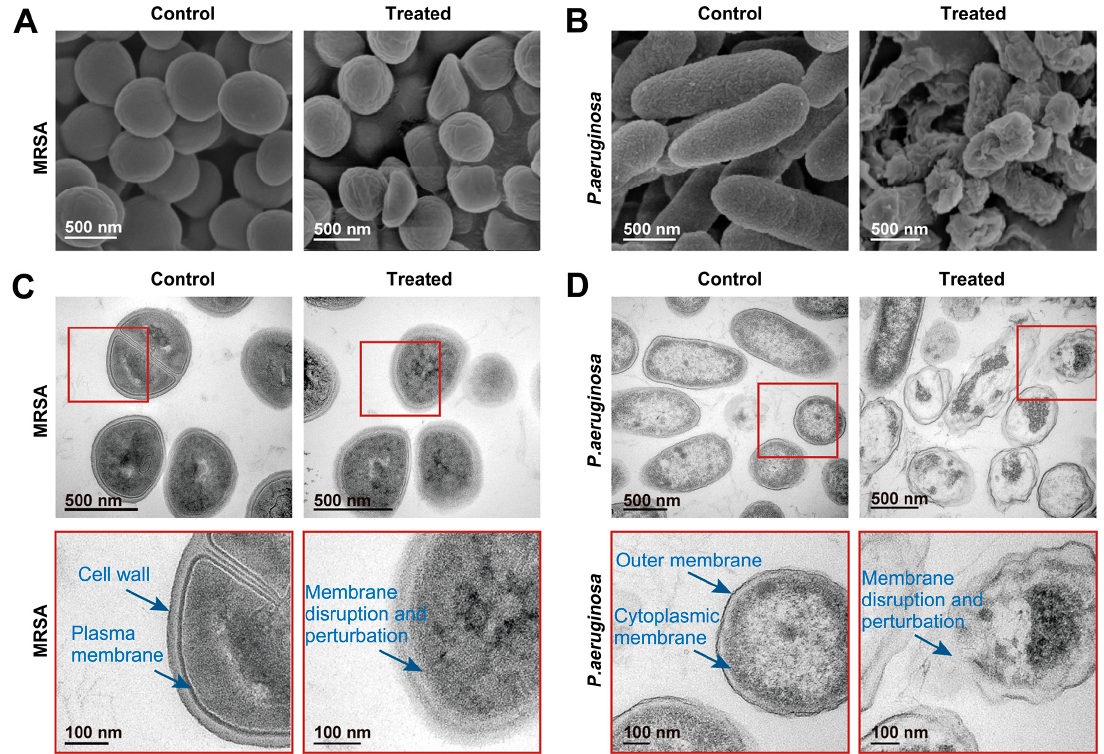
Figure 6. FE-SEM images of MRSA ( A ) and P. aeruginosa ( B ), and TEM images of MRSA ( C ) and P. aeruginosa ( D ) without and with MPLL- alt -PEG treatment.